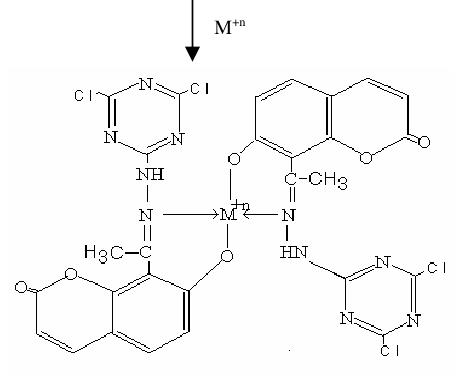
Scheme 1. Hydrazone and their chelates.